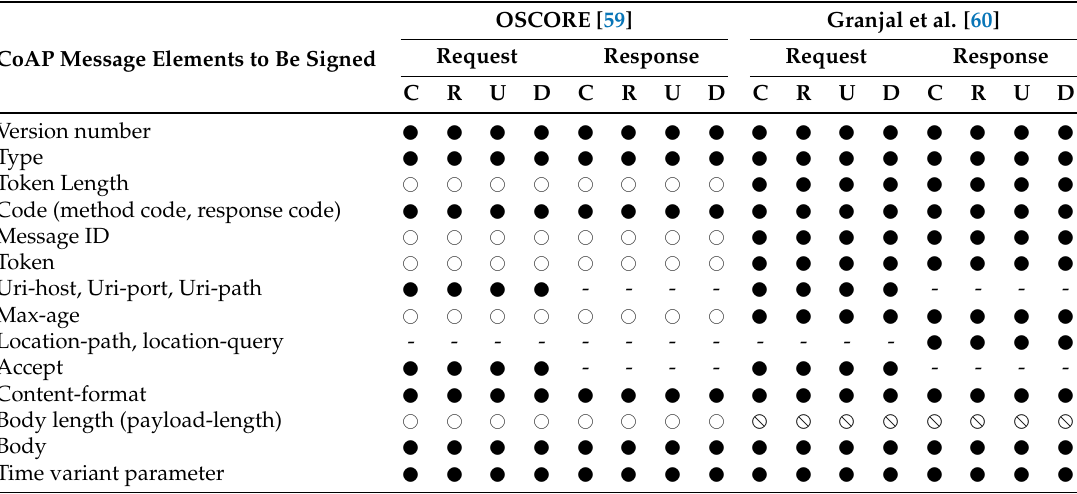
Table 3. Analysis of related work in constraint application protocol (CoAP) message authenticity and integrity.